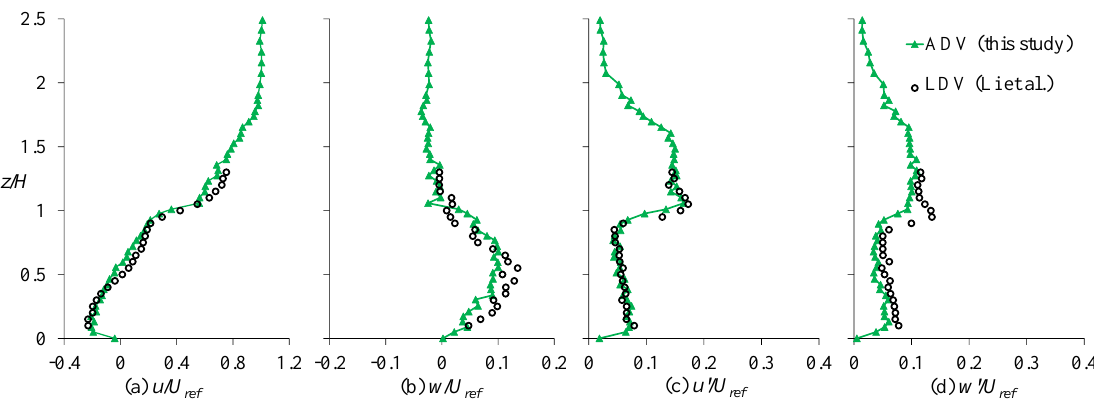
Figure 5. Normalized middle-line velocity profiles at canyon 4 measured with Acoustic Doppler Velocimeter (ADV, this study) and Laser Doppler Velocimeter (LDV, from Li et al. [36]). ( a ) mean stream-wise velocity, ( b ) mean vertical velocity, ( c ) stream-wise velocity fluctuation, and ( d ) vertical velocity